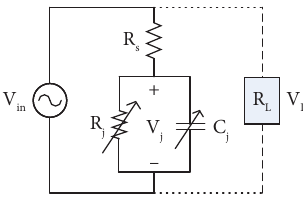
Figure 3: Equivalent circuit of the physical mode of SBD.